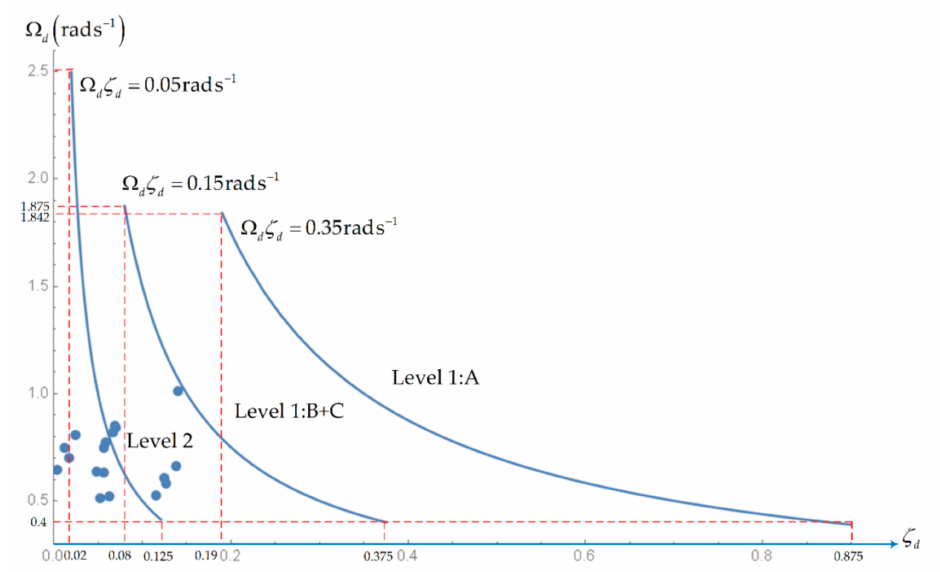
Figure 8. Level 1 and 2 Handling Qualities for the dutch roll